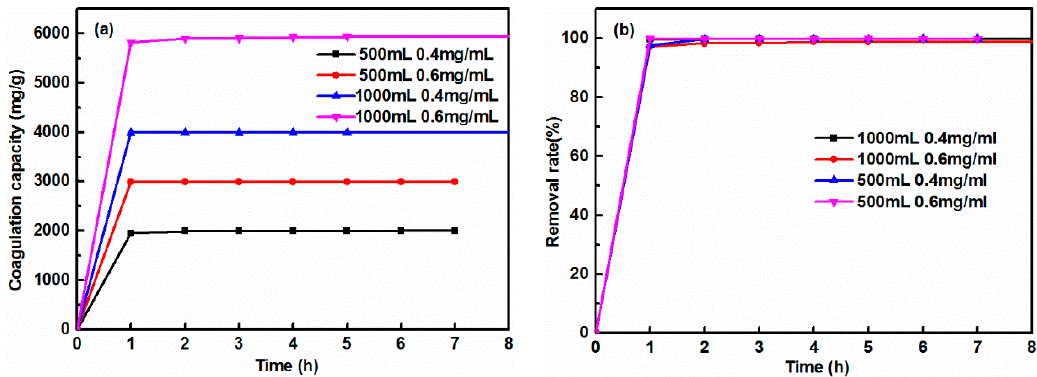
Figure 2. ( a ) Coagulation capacity, and ( b ) removal rate of GO vs. contact time using 0.1 g cement.